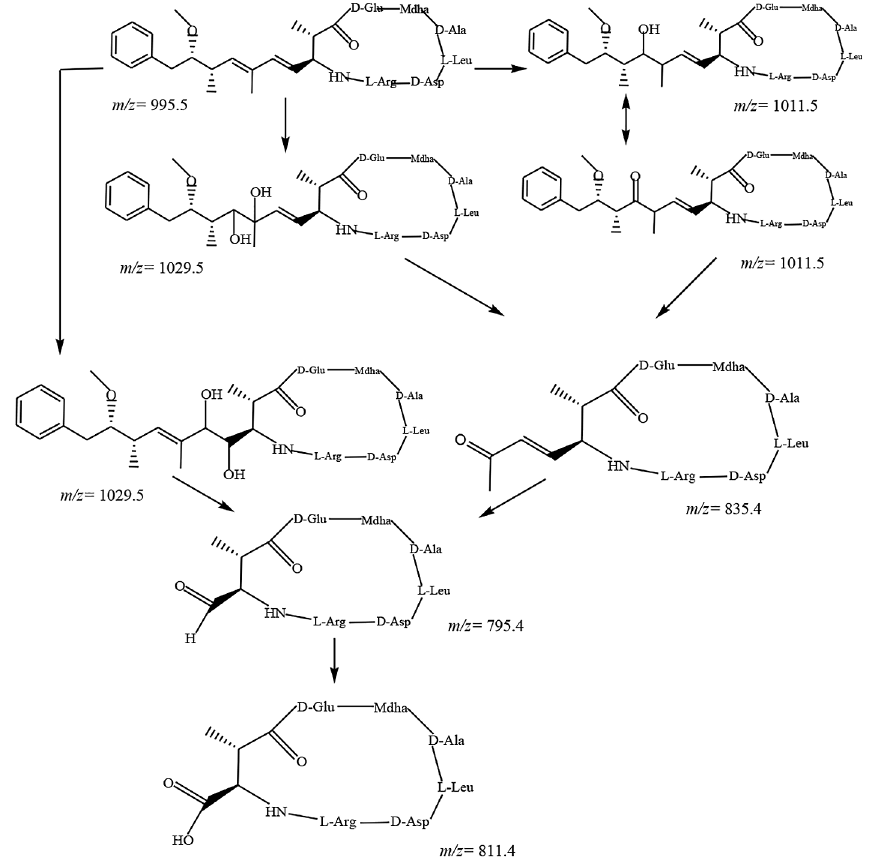
Fig 2. Byproducts and proposed reaction pathways for the combined UV/H 2 O 2 degradation of the conjugated carbon double bonds of Adda side chain of MCLR.